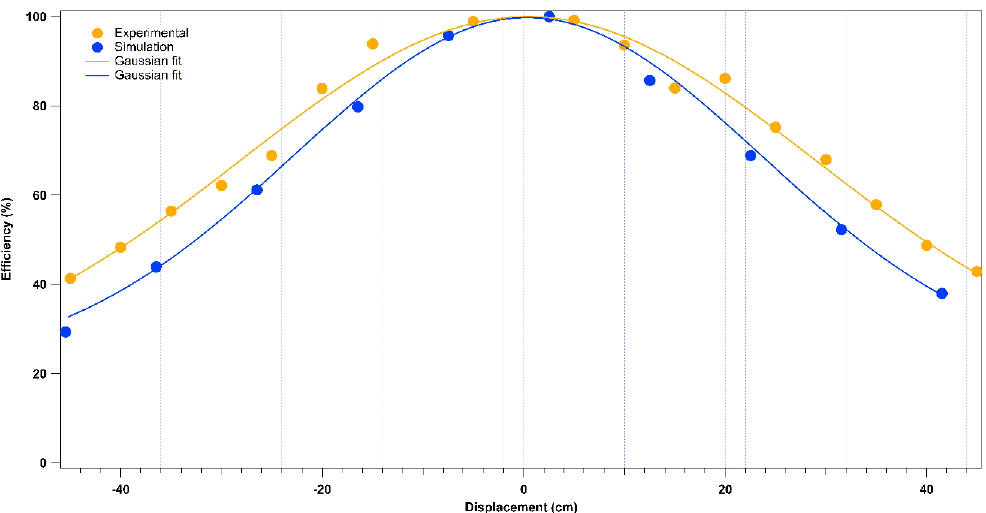
Figure 4. Experimental and simulated efficiency (%) in the Raman signal collection from the Teflon band at 731 cm − 1 for displacements from the optimized target-telescope distance